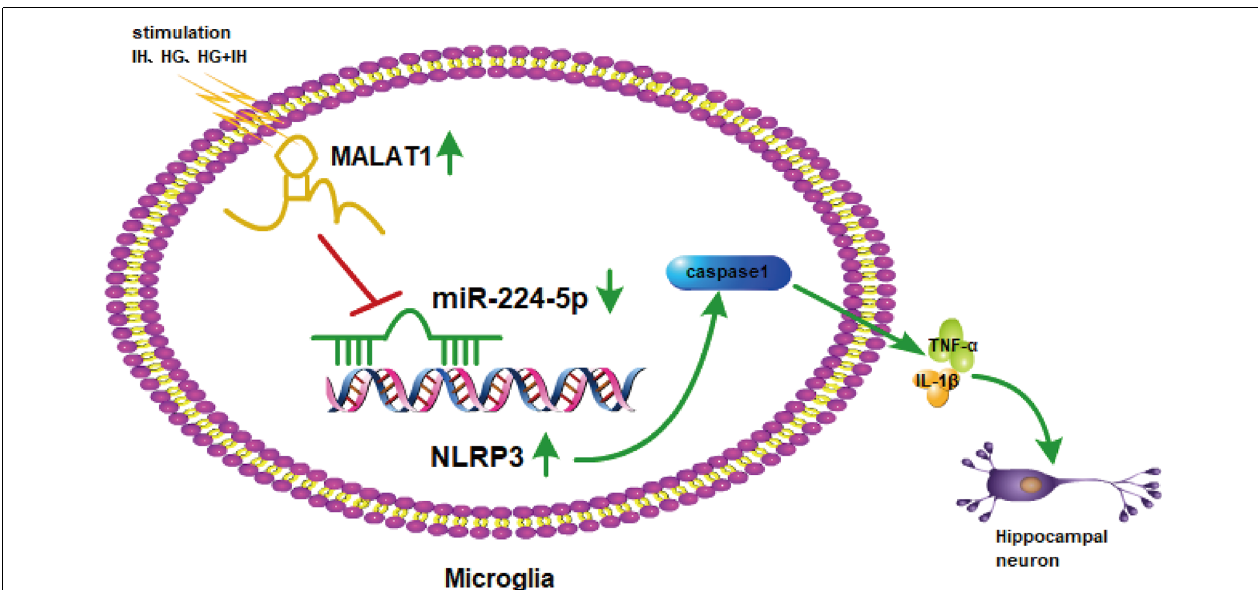
FIGURE 6 | The mechanism involved in hippocampal neuronal apoptosis induced by the MALAT1/miR-224-5p/NLRP3 axis after stimulation by HG combined with IH.